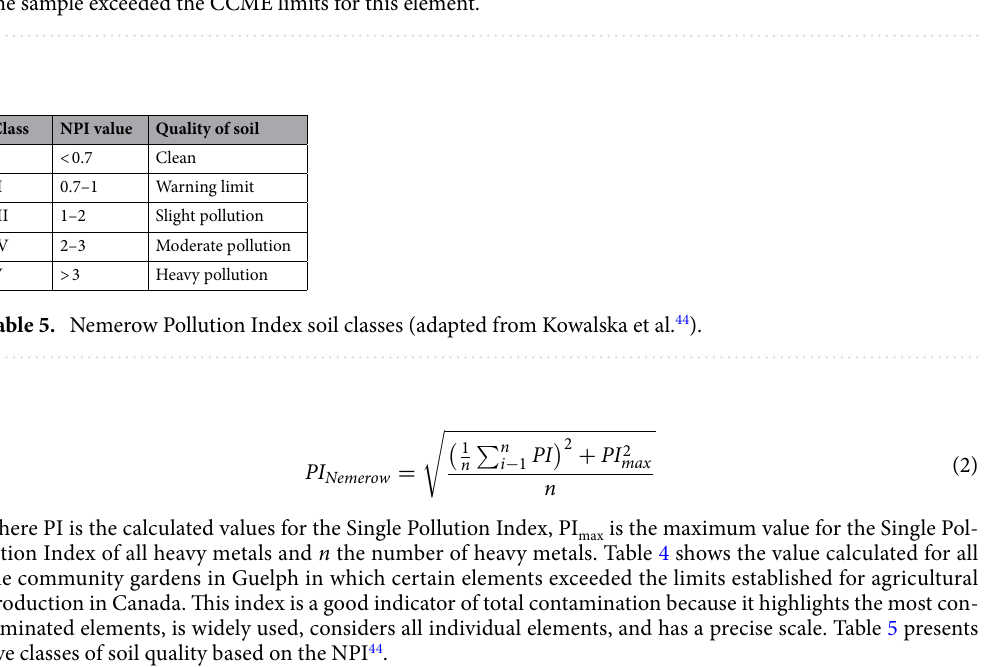
Table 4. Statistical analysis of the single pollution index (Pi) of each heavy metal surpassing the limits. a Only one sample exceeded the CCME limits for this element.